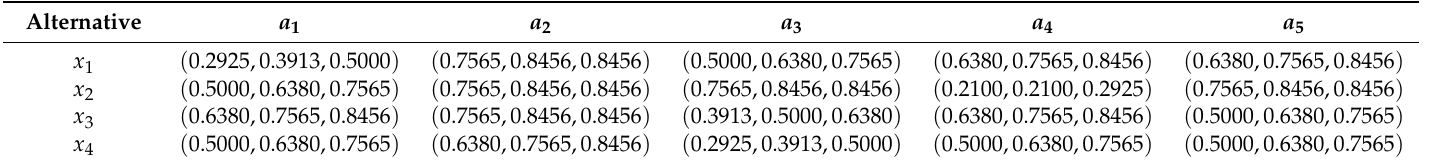
(cid:16) (cid:17) (cid:101) d ij 3 4 × 5